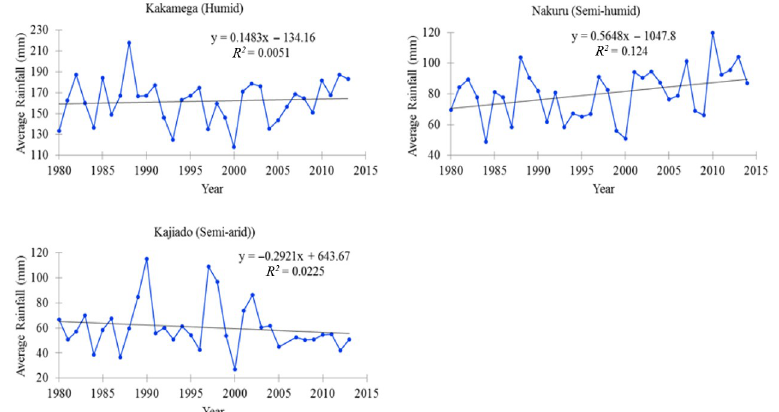
graphs showing average annual rainfall